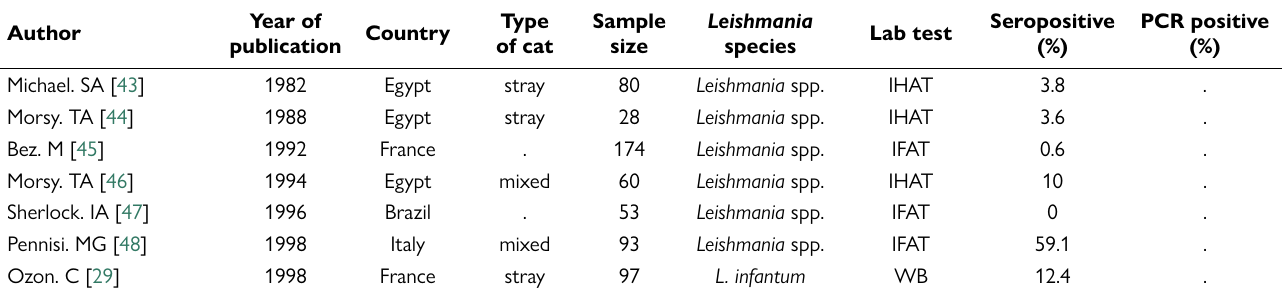
Table 1. Baseline characteristics of studies included in the meta-analysis of feline leishmanial infection